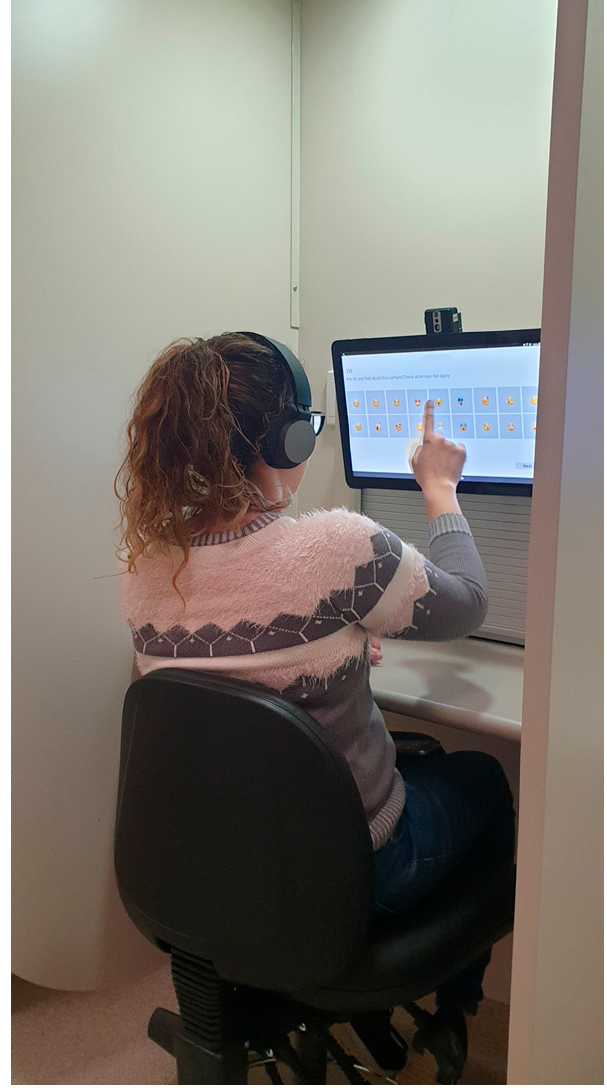
Figure 4. Participant in the booth during the sensory session using the integrated camera system and Bio-Sensory App.